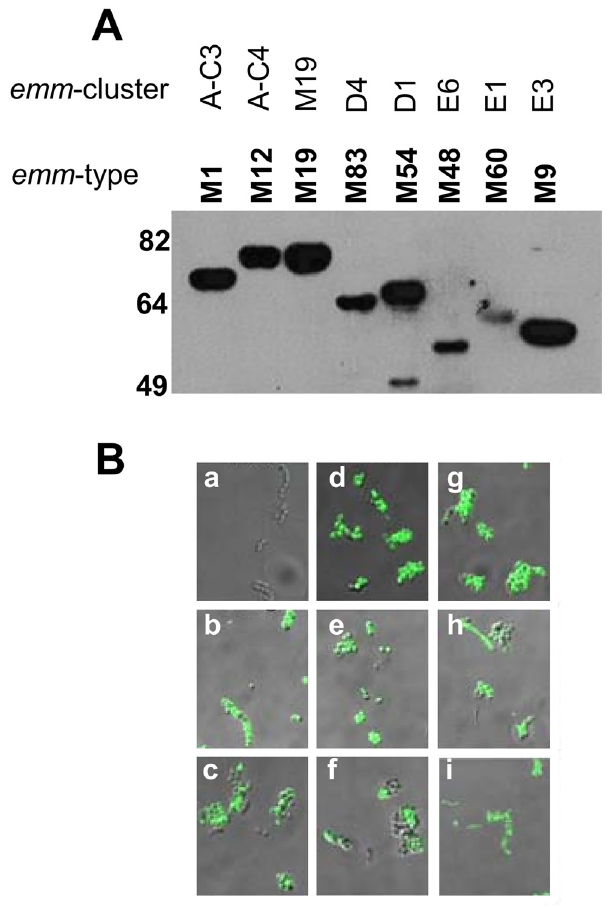
Fig 4. Anti-SV1 antibody binding to recombinant M-proteins and GAS surface. ( A ) M-proteins were electrophoresed in 12% SDS-PAGE gels transferred to nitrocellulose membrane and probed anti-SV1 antisera. The emm-type and emm -cluster assignment are shown at the top of the figure. ( B ) Immunofluorescent microscopy demonstrating that anti-SV1 antibodies bind to the surface of multiple GAS emm-types. The nine strains are (a) JRS145 ( emm -negative), (b) 5448, (c) PRS9, (d) PL1, (e) PRS30, (f) PRS42, (g) PRS15, (h), PRS20 and (i) PRS55. Images are shown as overlays of bright field and fluorescent images. No fluorescence was observed when PBS sera was used in the same assays (data not